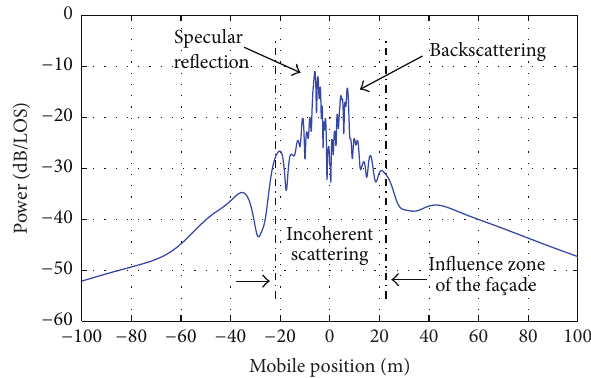
Figure 1: Narrow-band total scattered power received when passing next to a complex facade using ELSEM3D